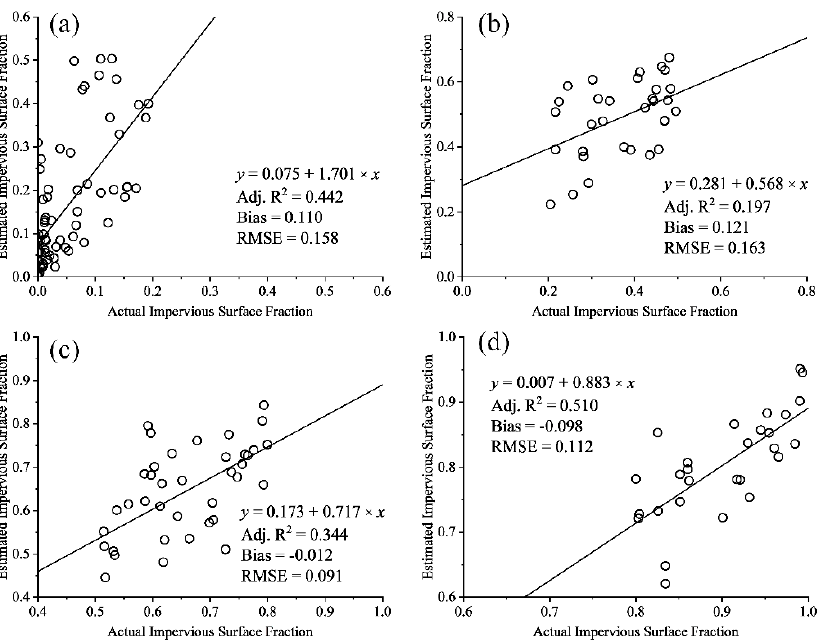
Figure 9. Scatter plot of accuracy assessment results for different impervious surface fractions from 170 sample areas: ( a ) 0–20%, ( b ) 20–49%, ( c ) 50–79%, ( d ) 80–100%.